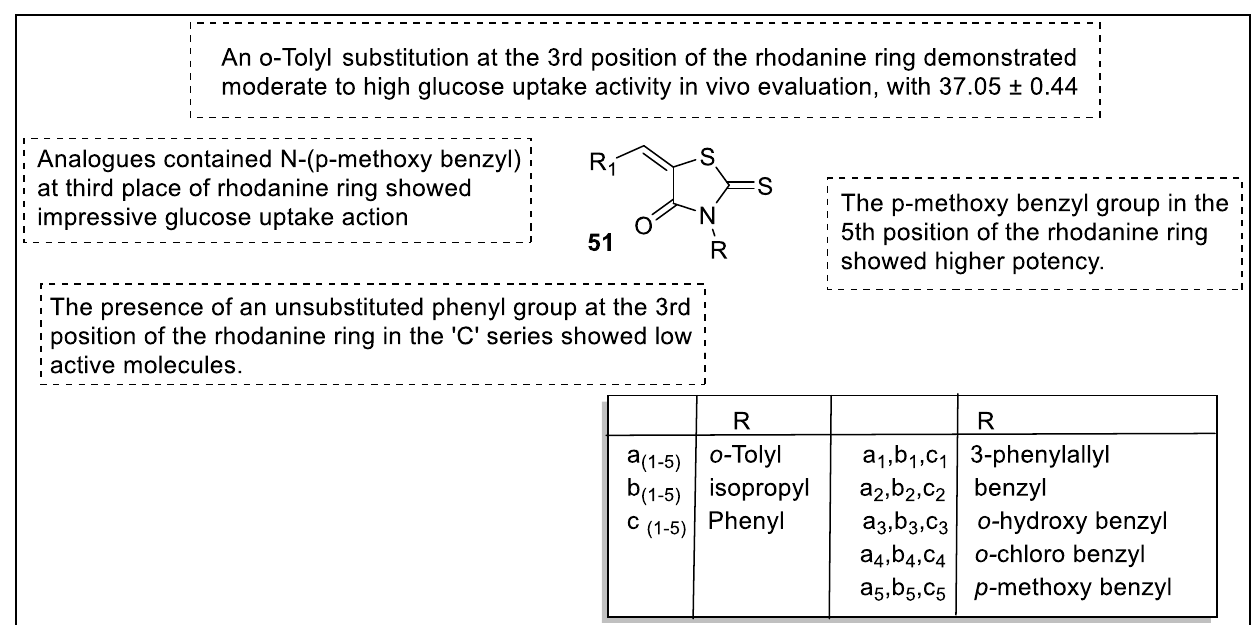
Figure 54. Structural activity relationship of triazole hybrids ( 50 ) as potent PPAR ligands.